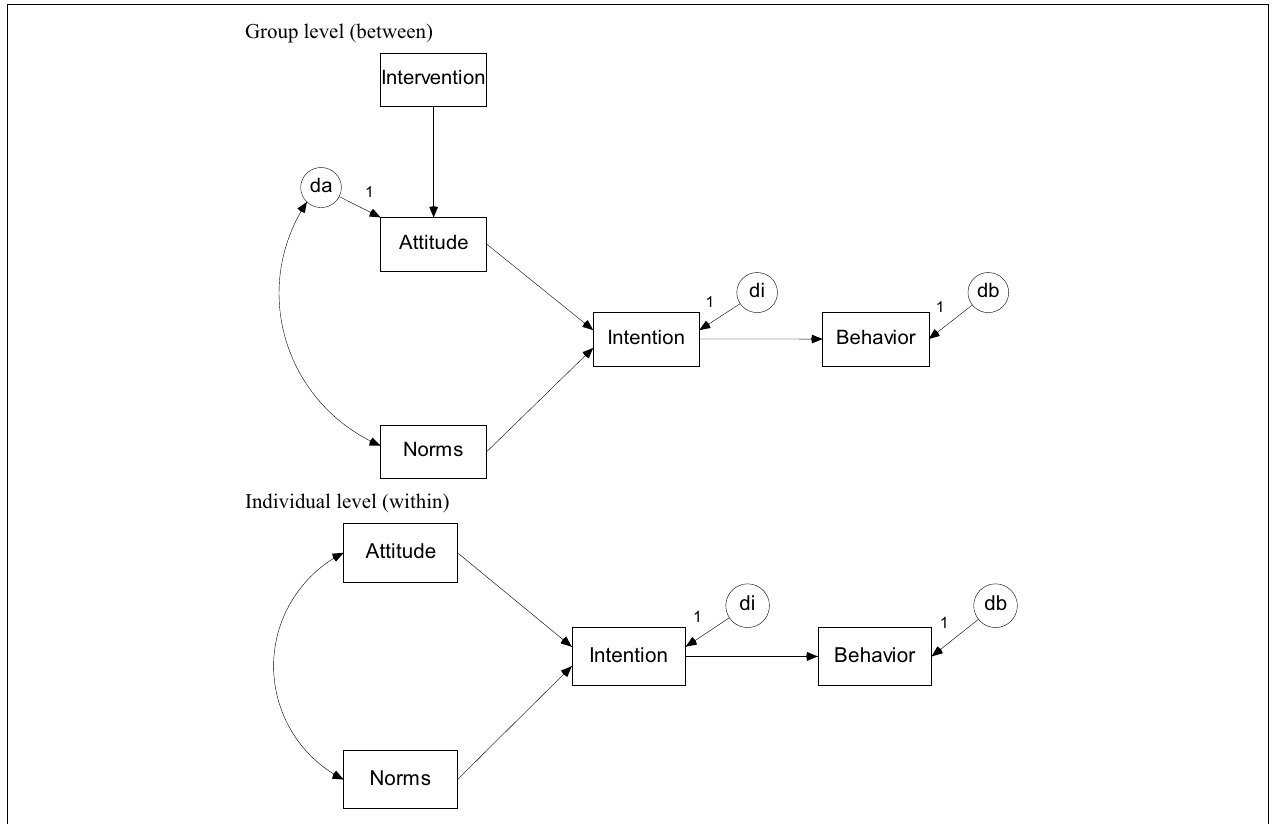
FIGURE 1 | The planned behavior model at the between-cluster level (Top panel) and within-cluster level (Bottom panel).